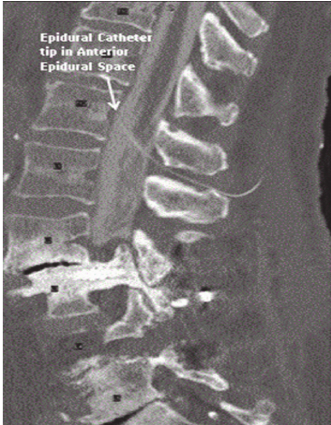
Figure 1: Epidural catheter tip positioned in the anterior epidural space with the catheter traversing the thecal sac. Note contrast only in the intrathecal compartment.